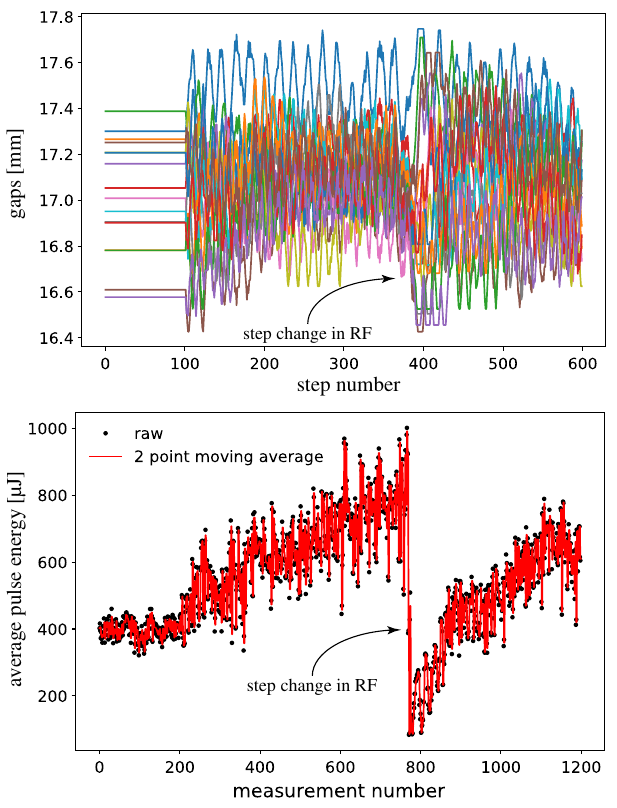
FIG. 7. Tuning 84 air coils to maximize average bunch